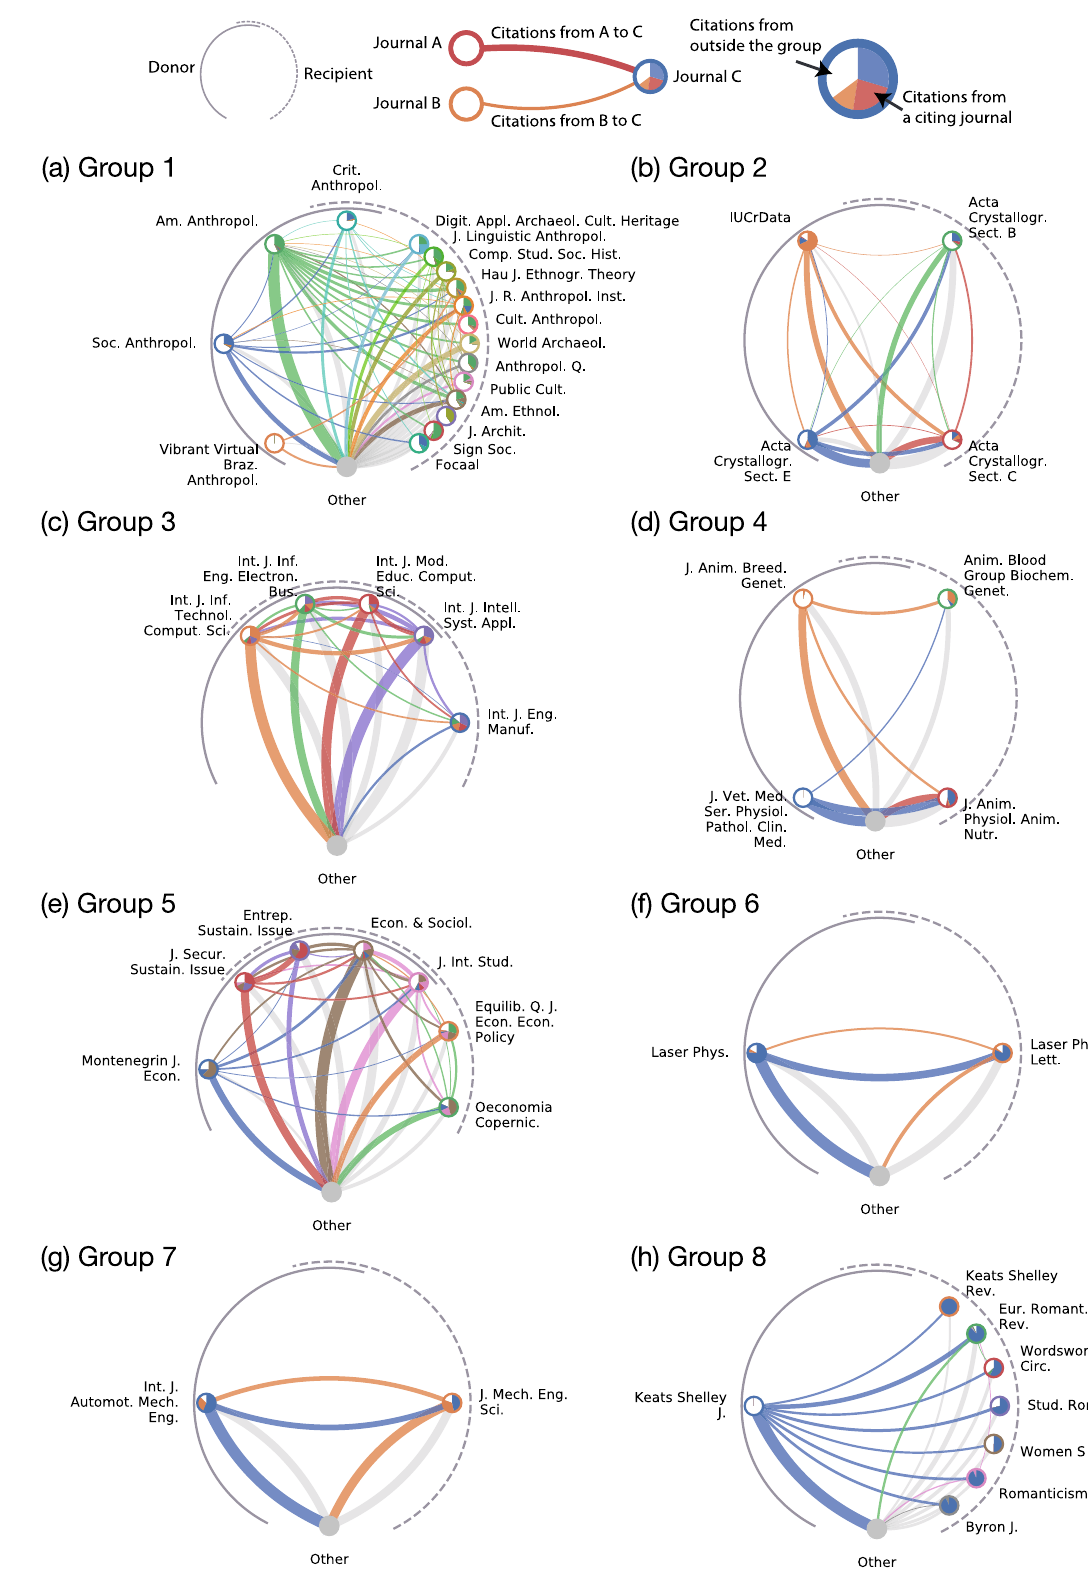
Figure 4. Citation groups detected by CIDRE. The circles indicate journals. The color of edges indicates the source of citations. The width of edges is proportional to the number of citations made between two journals. Self-citation edges are omitted. The pie in color within each circle indicates the share of citations from the citing journal from the viewpoint of the cited journal. The white pie within each circle indicates the share of citations from outside the group. The journals on the left and right arcs indicate the donor and recipient, respectively. The journals that are simultaneously donor and recipient are located where the arcs overlap. The journals outside the group are agglomerated into a gray-colored circle at the bottom of each